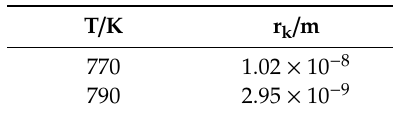
Table 3. Critical radii atoms contained in critical fluid core at di ff erent temperatures (770–790 K, 40 Pa)